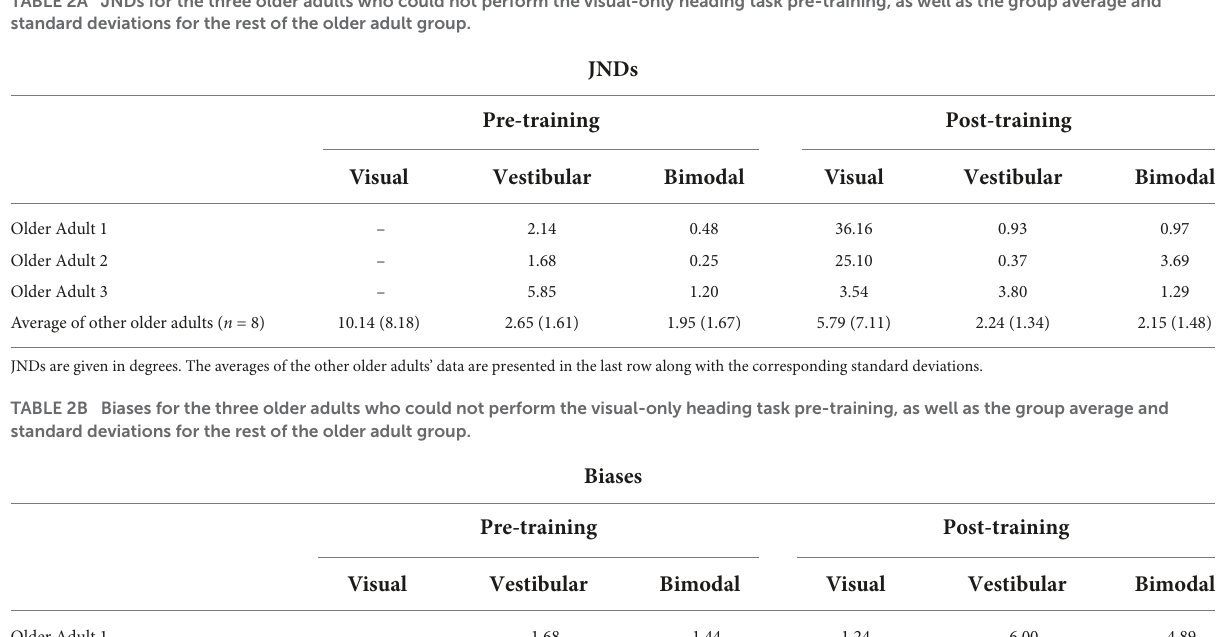
TABLE 2A JNDs for the three older adults who could not perform the visual-only heading task pre-training, as well as the group average and standard deviations for the rest of the older adult group.